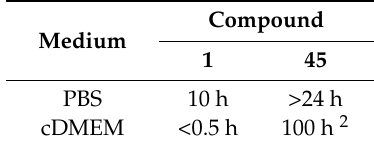
Table 5. Stability of compound 45 compared to quercetin in diverse media 1 .